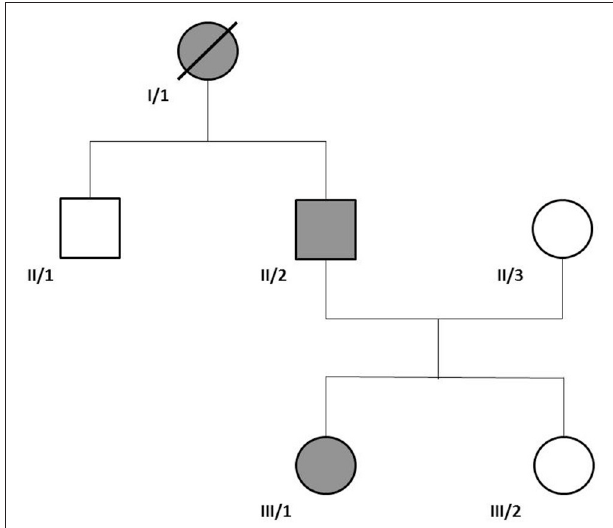
FIGURE 1 | Family tree of the affected family. We have examined patient II/2 and III/1. Family history suggested autosomal dominant